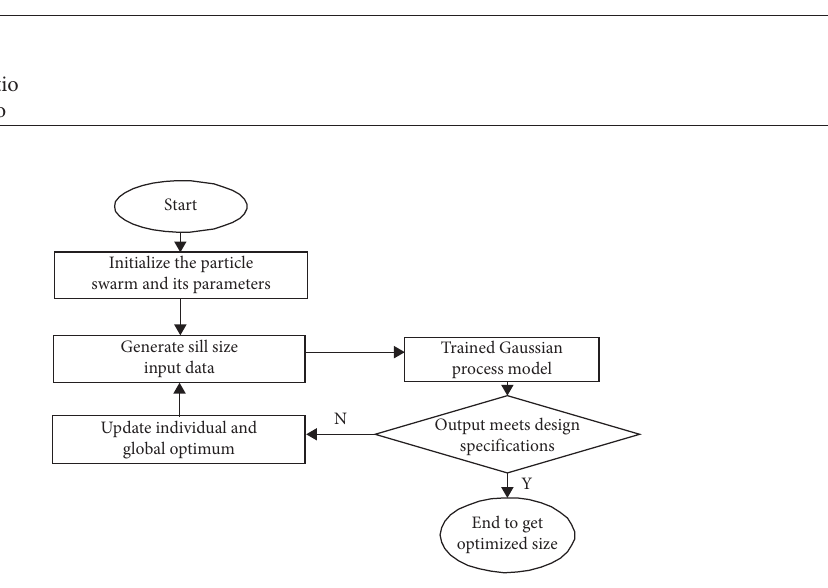
Figure 6: PSO-GP optimization